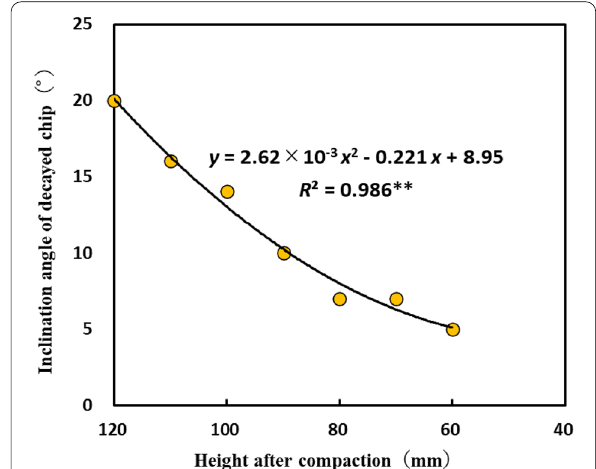
Fig. 9 Relationship between the height of the waste mushroom bed after compaction and inclination angle of the decayed